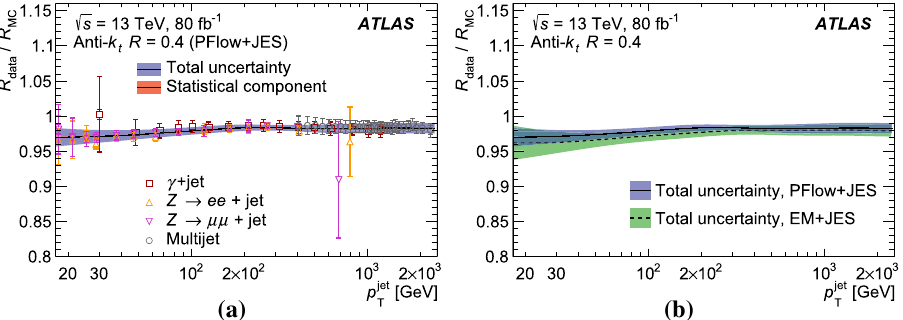
Fig. 20 a Ratio of the PFlow+JES jet response in data to that in the nominal MC event generators as a function of jet p T for Z +jet, γ +jet, and multijet in situ calibrations. The inner horizontal ticks in the error bars give the size of the statistical uncertainty while the outer horizontal ticks indicate the total uncertainty (statistical and systematic uncertain-